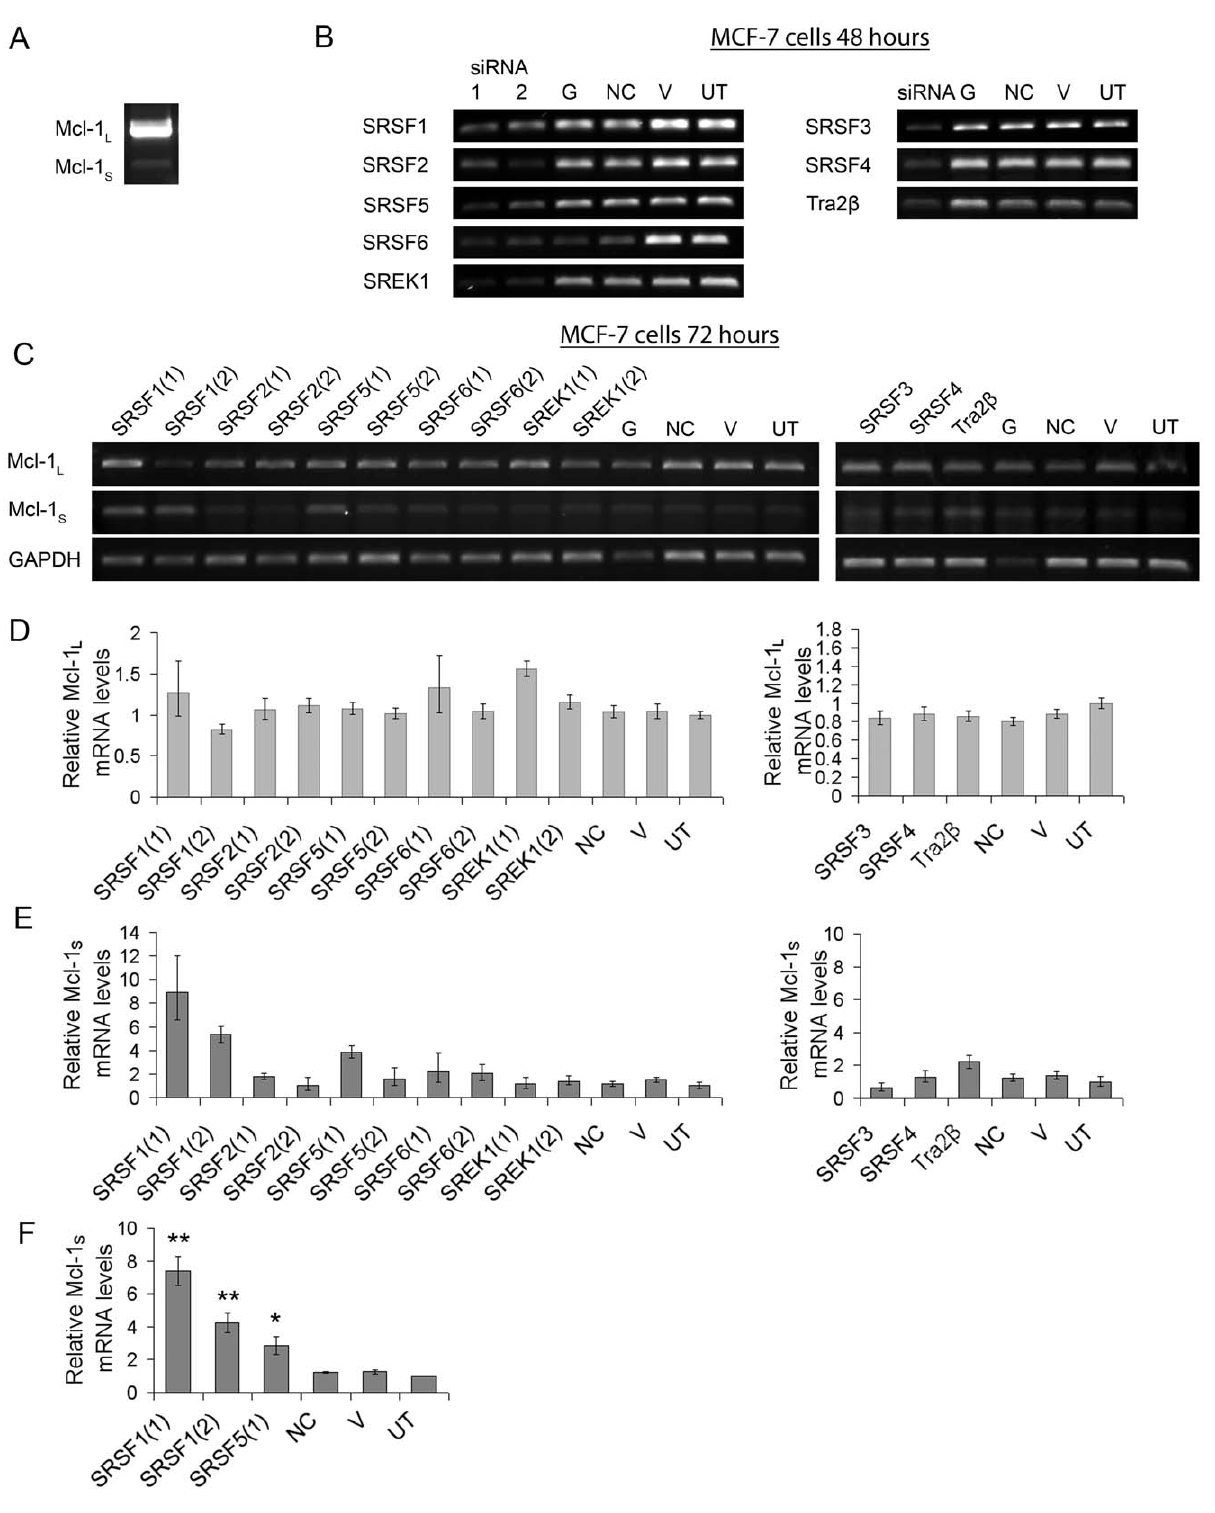
Figure 3. Knockdown of RNA binding proteins in MCF-7 cells and their effect on the mRNA levels of Mcl-1 splice isoforms. MCF-7 cells were transfected with SRSF1-6, Tra2 b , SREK1, GAPDH (G) and Negative control (NC) siRNAs, or treated with vehicle (lipid) only (V), or were left untreated (UT). (A) Semi-quantitative RT-PCR showing both Mcl-1 spliced variants. ( B ) Semi-quantitative RT-PCR showing knockdown of RNA binding proteins 48 hours after transfection with siRNAs. ( C ) Semi-quantitative RT-PCR showing levels of the Mcl-1 splice isoforms (Mcl-1 L and Mcl-1 S ) and the loading control GAPDH 72 hours after transfection with siRNAs. ( D ) Mcl-1 L levels measured by real-time PCR on the same sample shown in (B). ( E ) Mcl-1 S levels measured by real-time PCR on the same sample shown in (B). ( F Mcl-1 S levels in sample replicates measured by real-time PCR (mean (n=3) 6 SEM). ** P # 0.01; * P # 0.01.